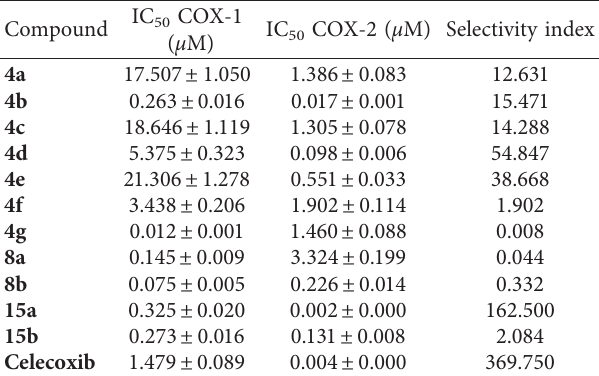
Table 1: In vitro activity on COX-1 and COX-2 with selectivity